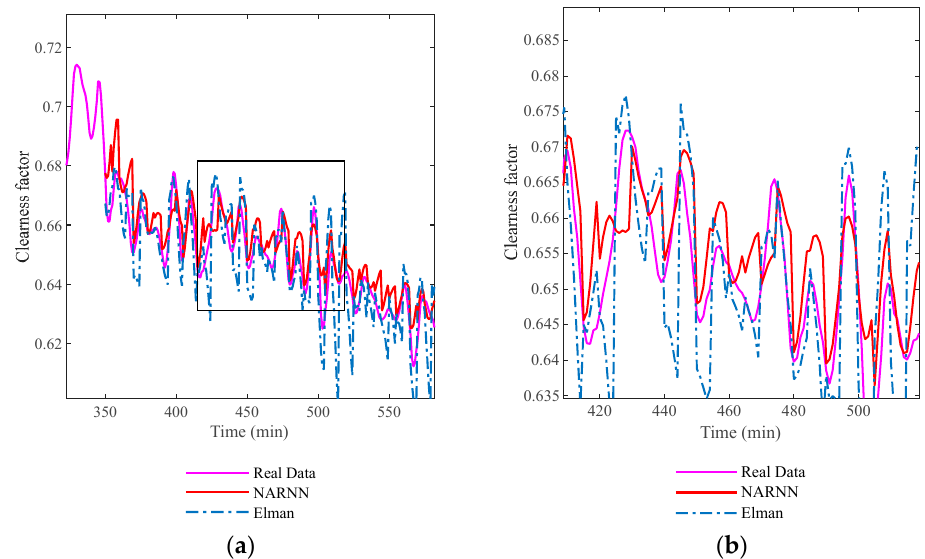
Figure 7. Five ‐ step ‐ ahead prediction of M2, M4 using EMD ( a ) and partial enlarged figure ( b ).